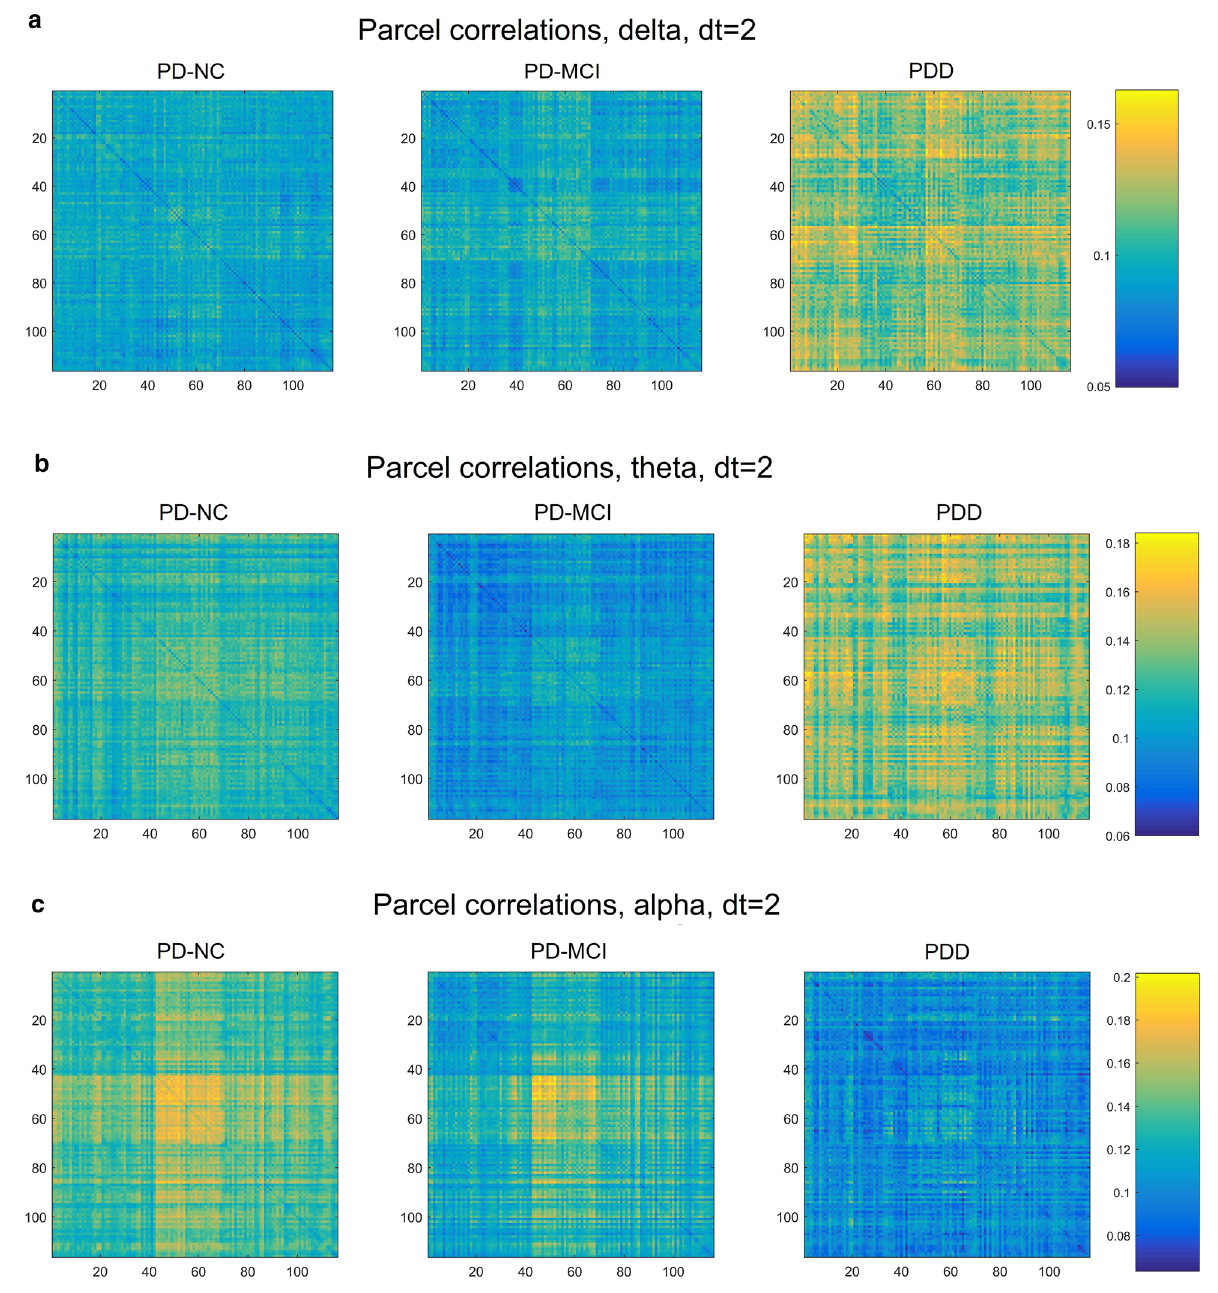
Figure 6. AAL parcel-correlation maps showing most substantial correlation differences among the five frequency bands [( a ) delta, ( b ) theta, ( c ) alpha, ( d ) beta, ( e ) gamma]. Vertical axis represents the earlier state of the parcel, while horizontal axis represents the